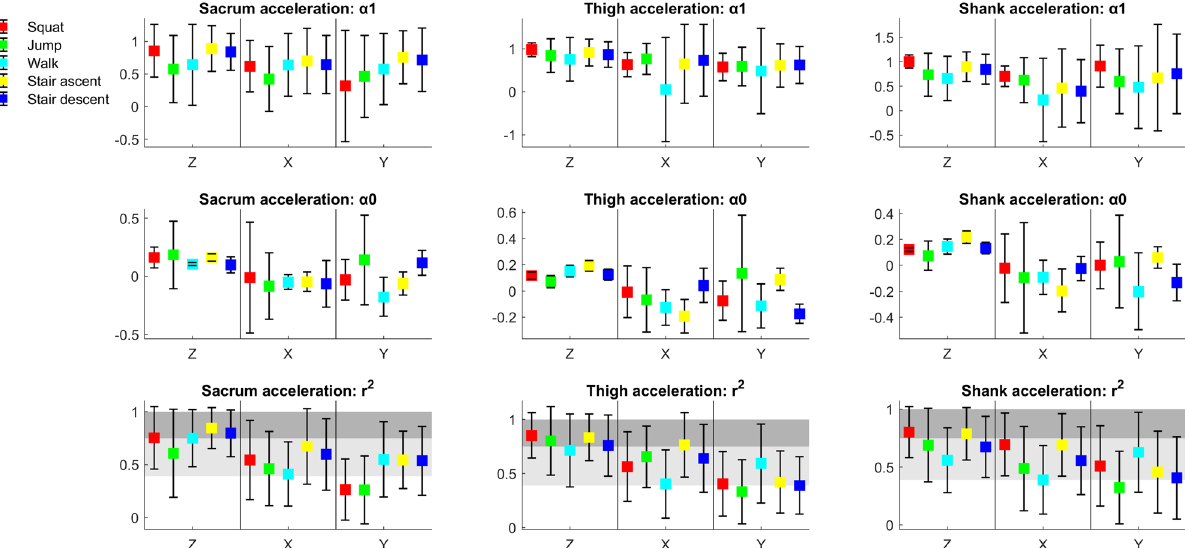
Figure 1. Means (squares) and standard deviations (markers of α1, α0 and r 2 for individual participants’ acceleration waveforms; light grey shaded areas indicate fair-to-high concurrent validity; dark grey shaded areas indicate excellent concurrent validity; if DOT is identical to MTw then the values of LFM parameters are α1 = 1, α0 = 0, r 2 = 1, for the full interpretation of the parameter’s values, please see statistical analyses in the methods section.